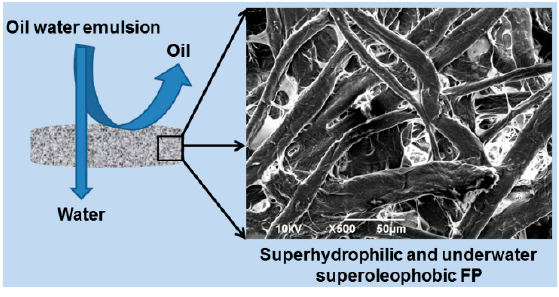
Figure 2. Schematic representation of the separation of oil and water from a non-stabilized oil-in-water emulsion.